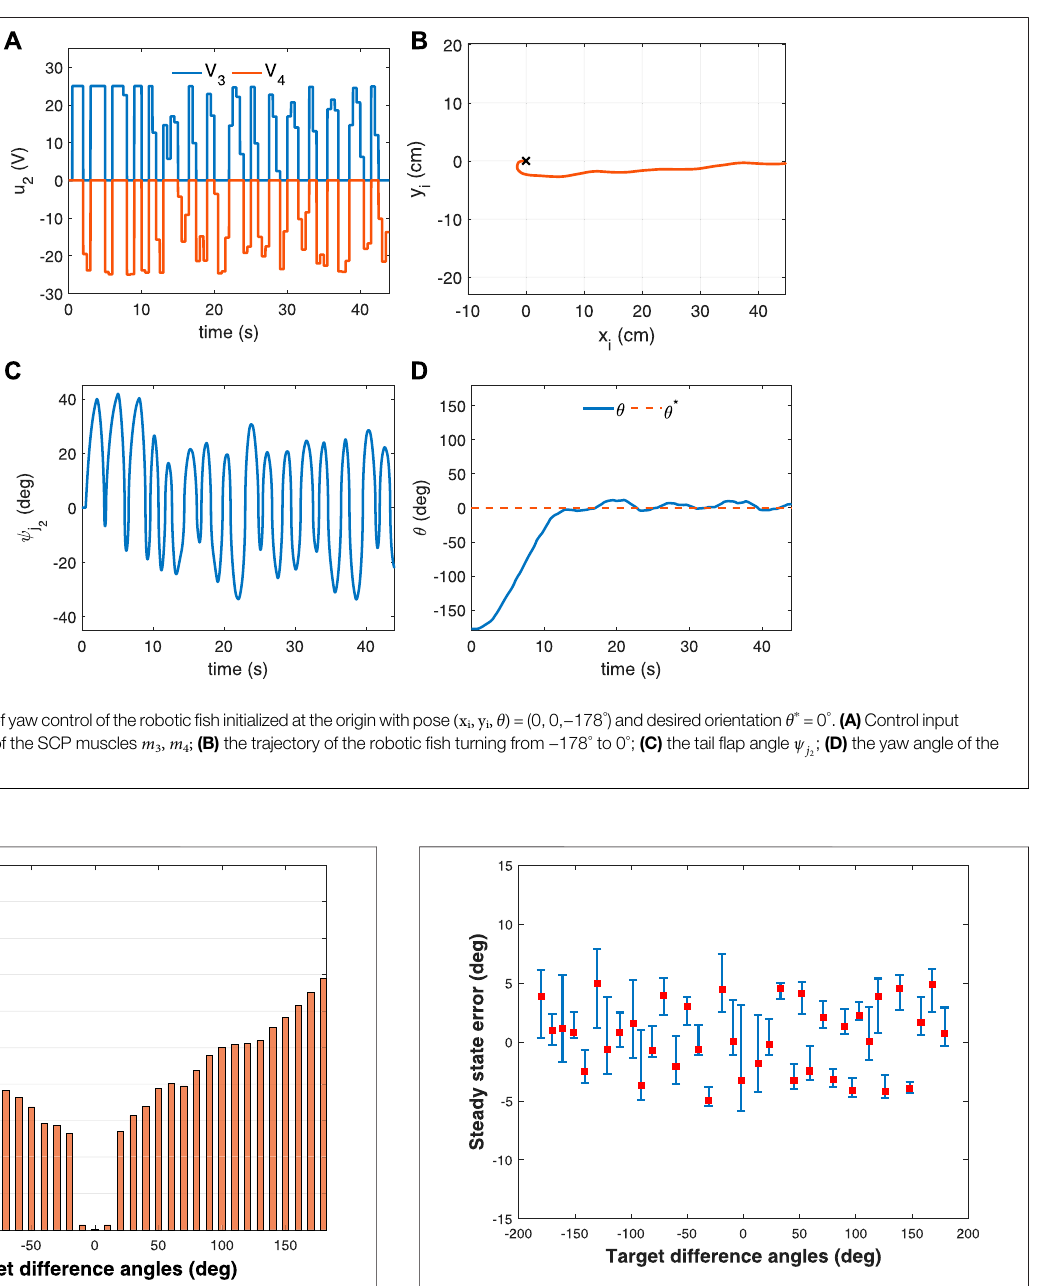
FIGURE 8 | Simulated result of the settling times in yaw control of the soft robotic fi sh initially oriented at zero degrees and targeted to swim at every angle spaced by 10 degrees in the range ( − 180 ° , 180 ° ).